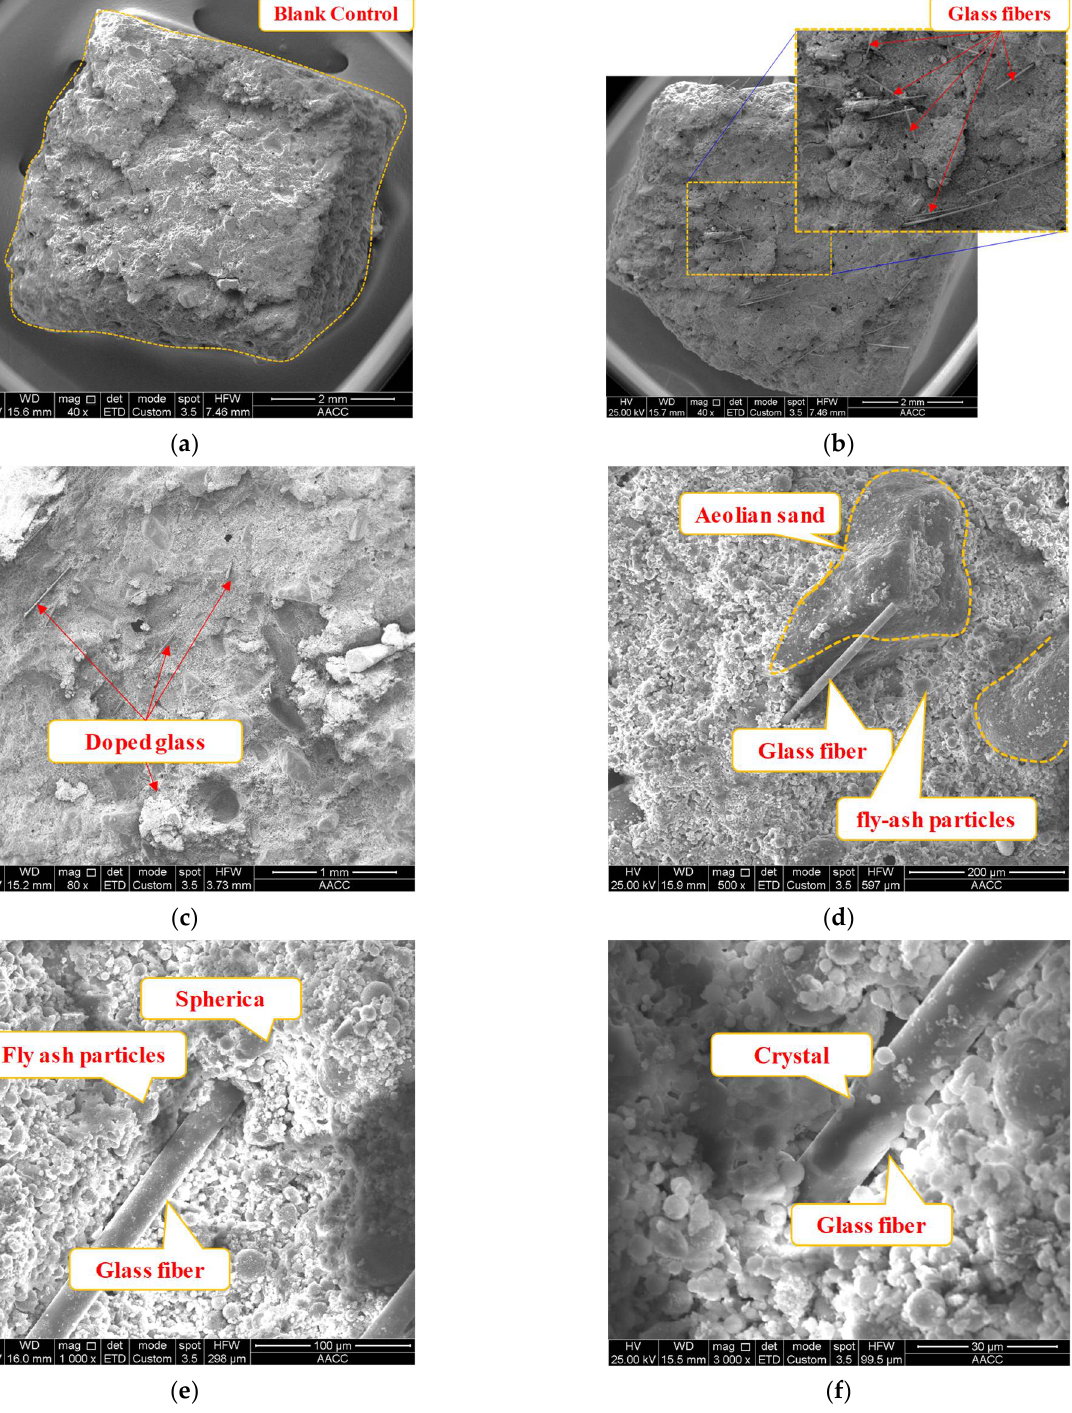
Figure 15. Matrix–glass fiber adhesion features during tensile tests under different magnifications. ( a ) Blank control; ( b ) Overall distribution of glass fibers×40; ( c ) ×80; ( d ) ×500; ( e ) ×1000; ( f ) ×3000.